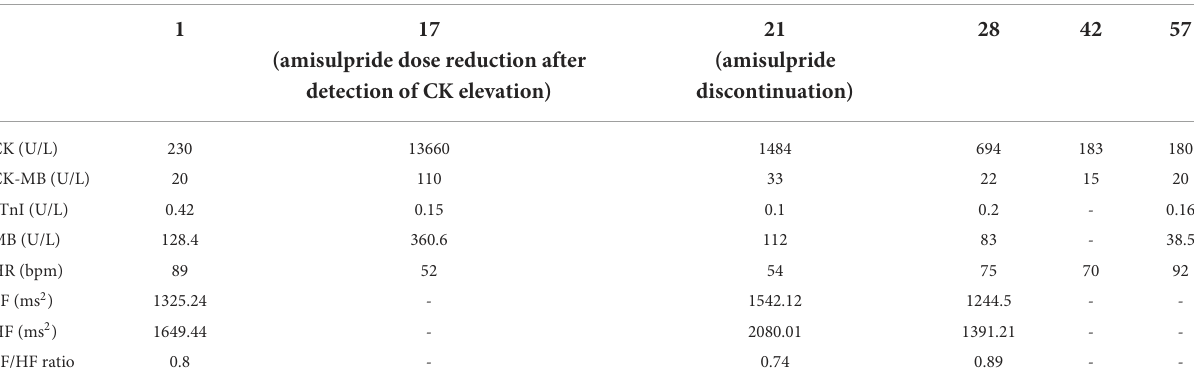
TABLE 1 Timeline of relative